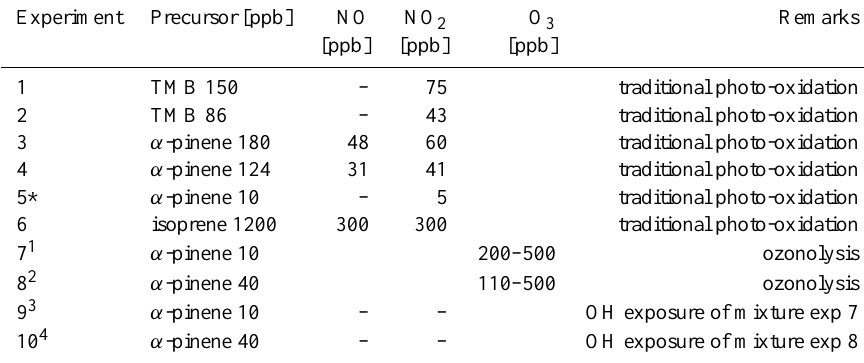
Table 1. Experimental conditions for SOA formed in the smog